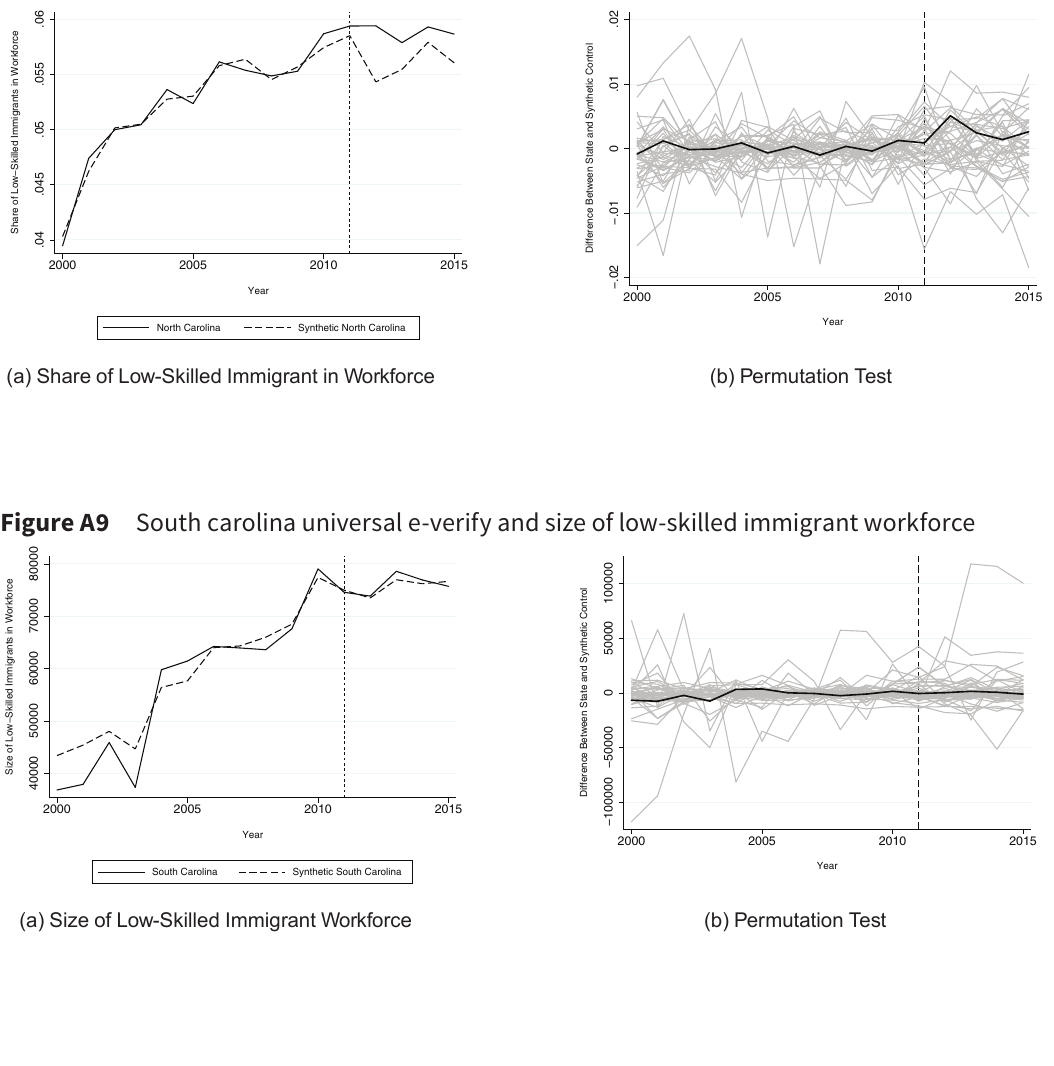
Figure A8 North carolina universal e-verify and share of low-skilled immigrants in workforce